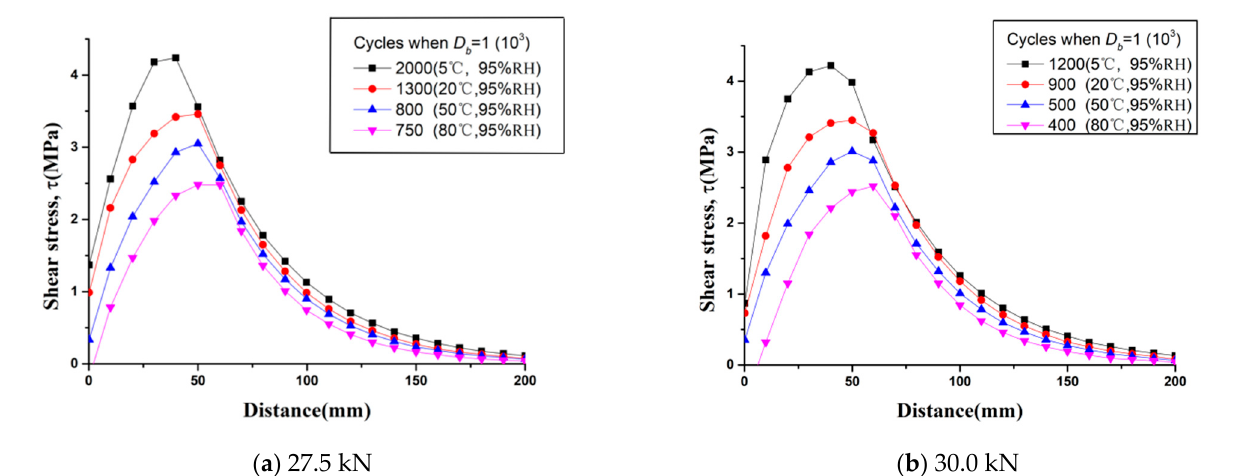
Figure 8. Shear stress distribution of CFRP–concrete interface in theory when D b = 1: ( a ) 27.5 kN; ( b ) 30.0 kN. ( b ) 30.0 kN.